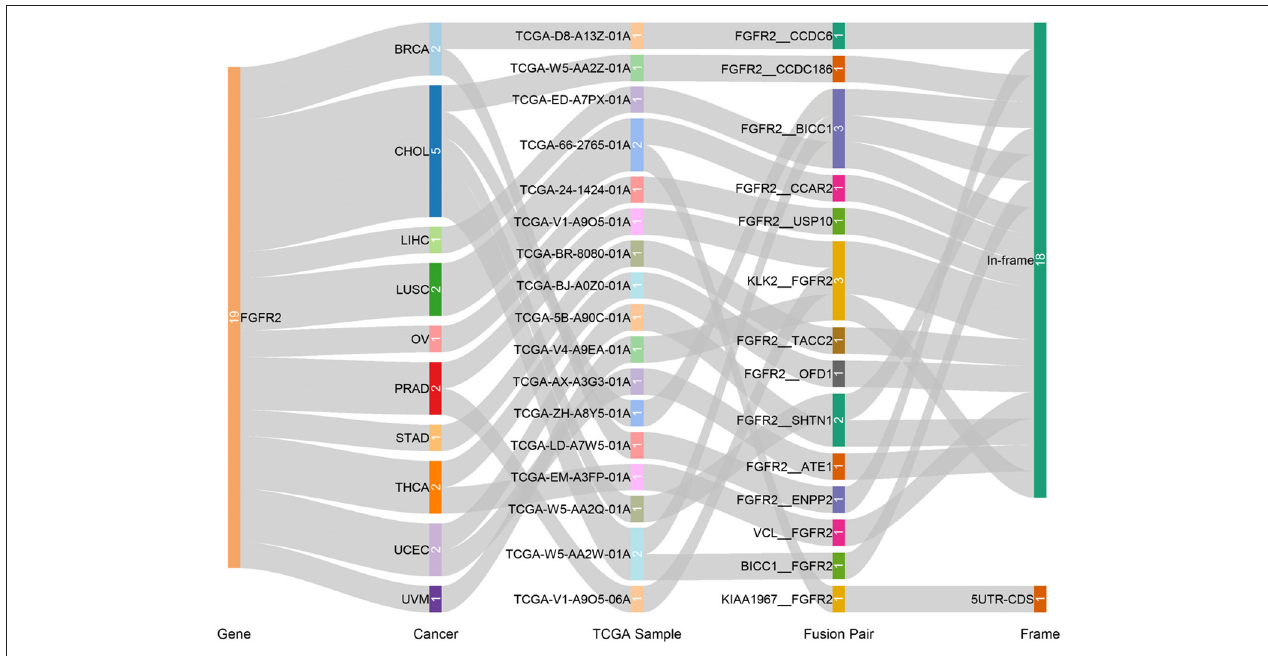
FIGURE 4 | Fusion gene of FGFR2 in TCGA cancer